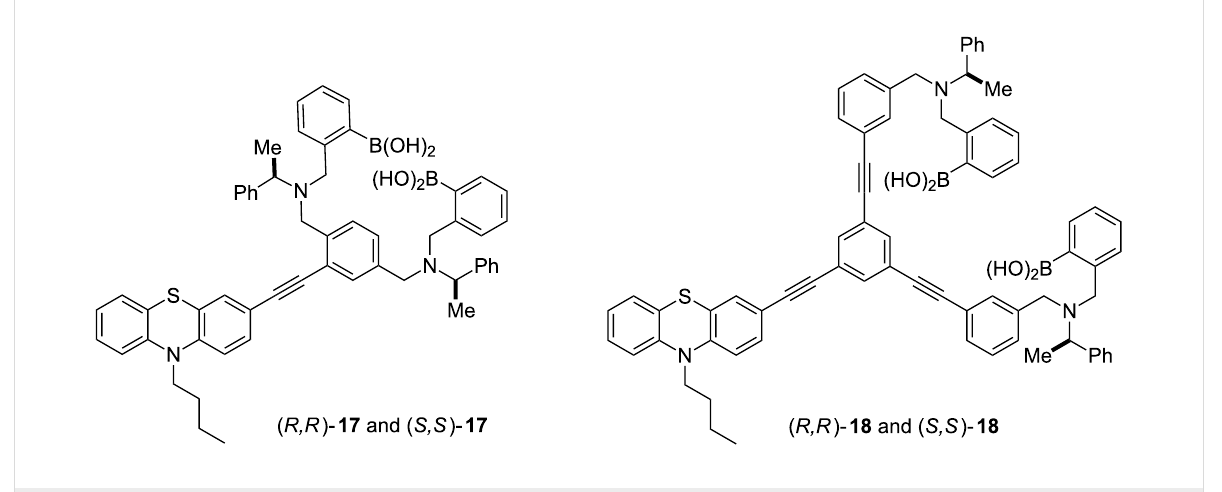
Figure 12: Modular chiral discriminating d-PET systems (relative stereochemistry shown).